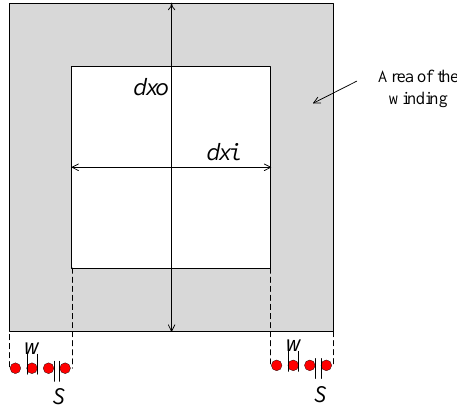
Figure 10. Diagram of the square coil parameters.